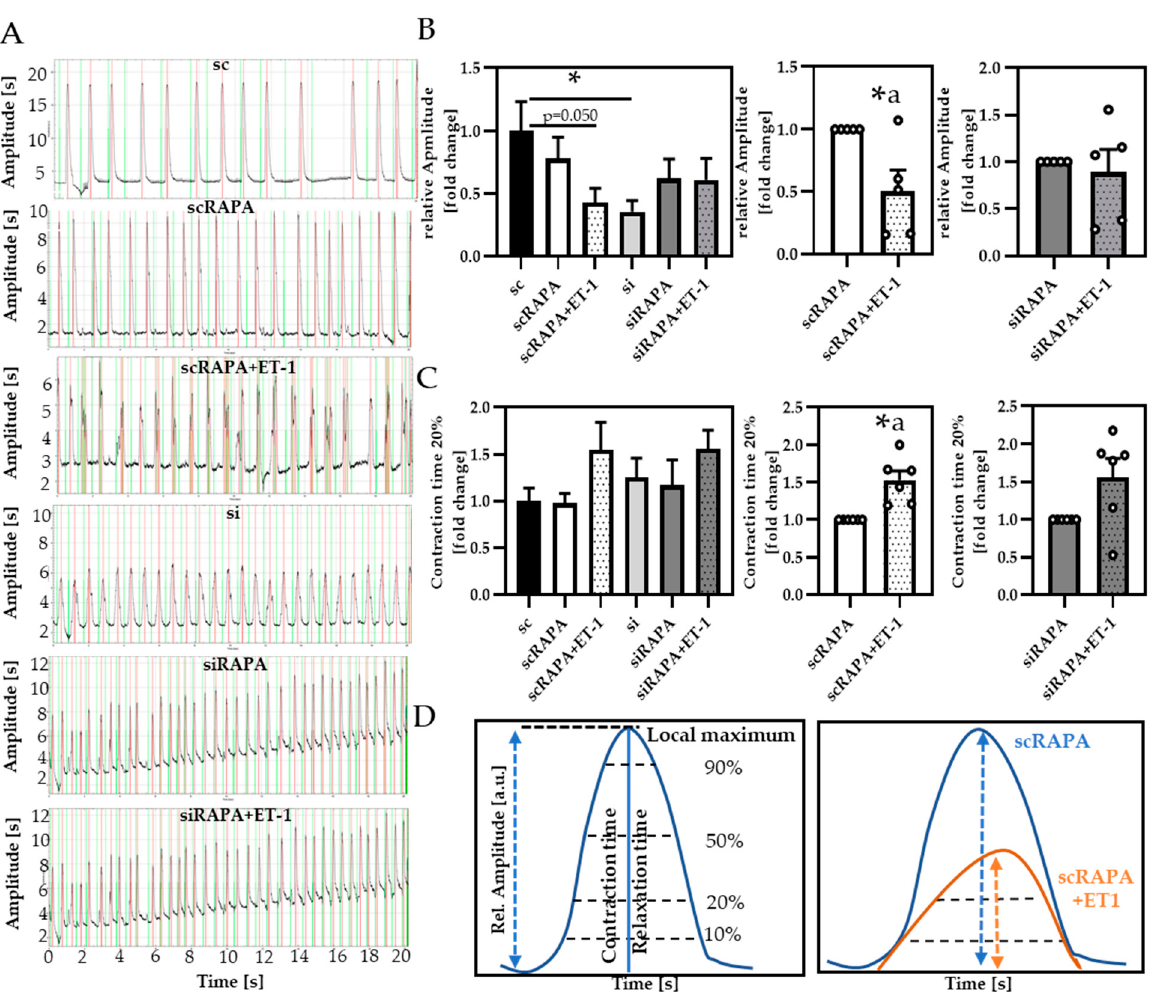
Figure 6. Atg5 siRNA and ET-1 decreased cardiomyocyte contractility by downregulation of autophagy. ( A ) Representative contraction profiles of the respective conditions, red local maxima, green local minima. ( B ) Relative amplitude of contraction and ( C ) Contraction time 20% (CT20). ( D ) Illustration of movement parameters analyzed in spontaneously contracting neonatal cardiomyocytes, using Myocyter. All data are presented as Mean + SEM of biological replicates and statistical analyses were performed be either one-way-ANOVA followed by Tukey’s posttest or One-sample t -test (indicated with a). Statistically significant differences are shown by p < 0.05, * vs. sc or scRAPA and p = 0.050 comparing sc vs. scRAPA + ET-1, using Unpaired t -test.